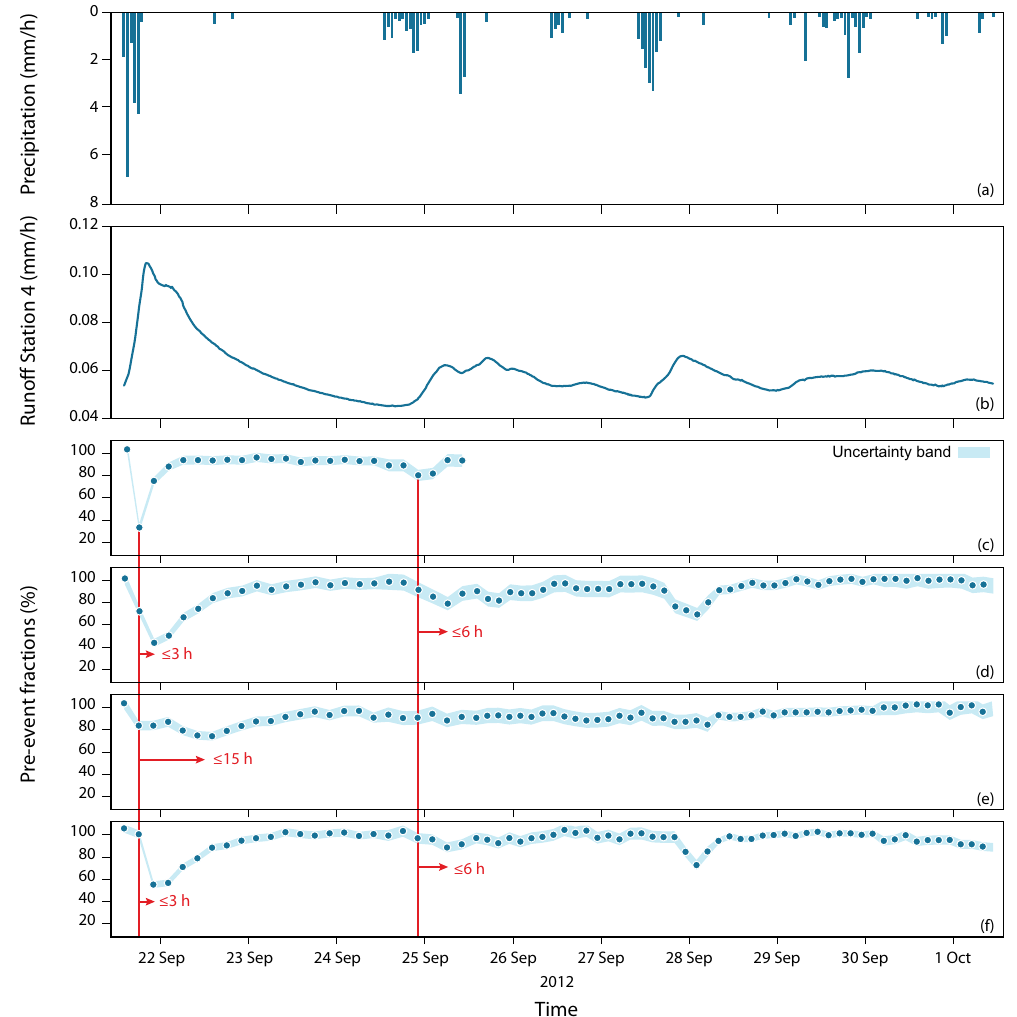
Figure 7. Runoff and precipitation characteristics and pre-event fractions for the September event. (a) Hourly precipitation measured 6km northwest of station 4. (b) Catchment runoff measured at station 4. (c–f) Pre-event fractions for stations 1, 2, 3 and 4, respectively. Lag times between peak responses are indicated with red